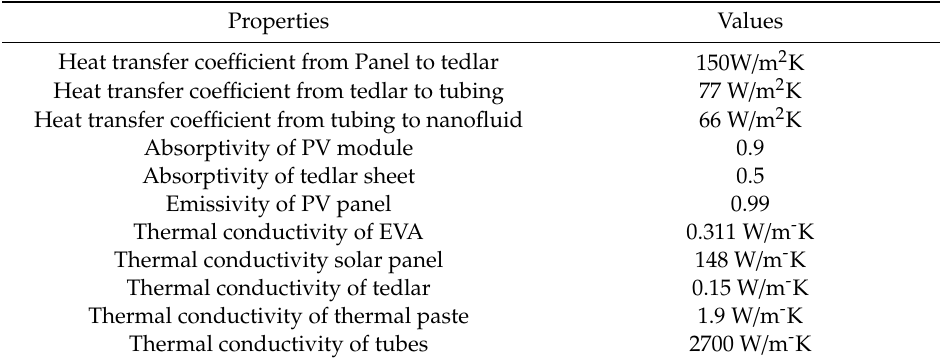
Table 4. Thermal and optical properties of PV / T